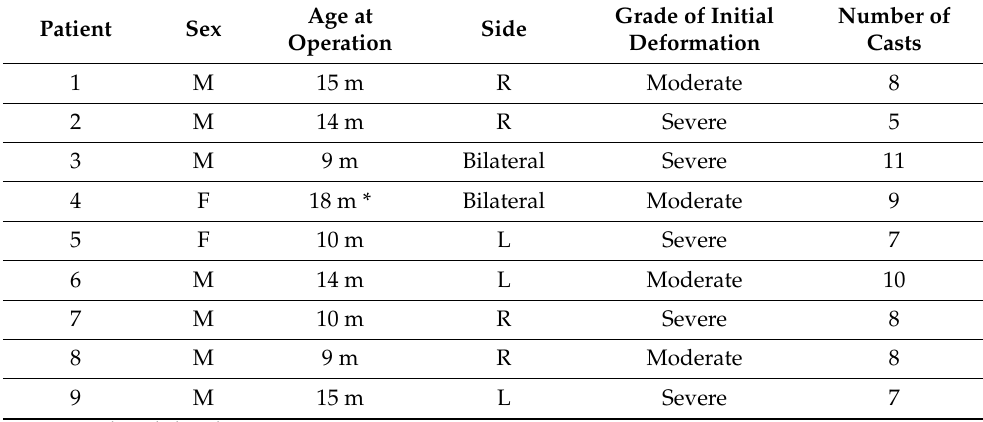
Table 1. Patient Characteristics.